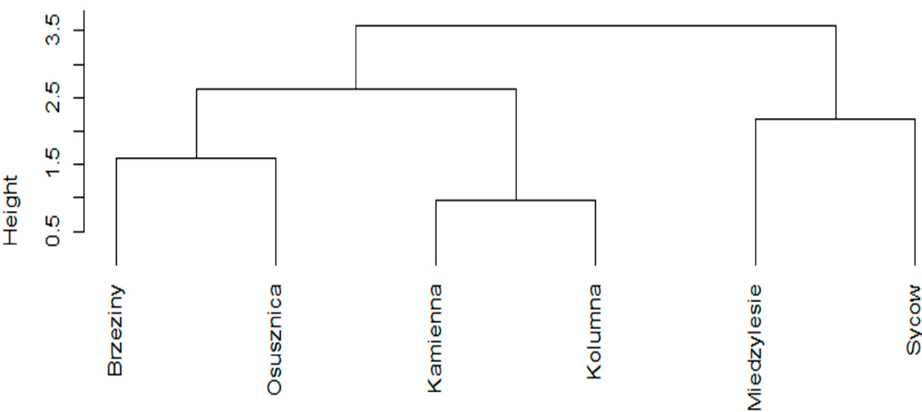
Figure 7. Dendrogram of cluster analysis using complete linkage clustering for needle traits: leaf mass-to-area, total chlorophyll concentration, and maximal electron transfer rate ( LMA , Chl tot , ETR max ). Agglomeration coefficient = 0.6.